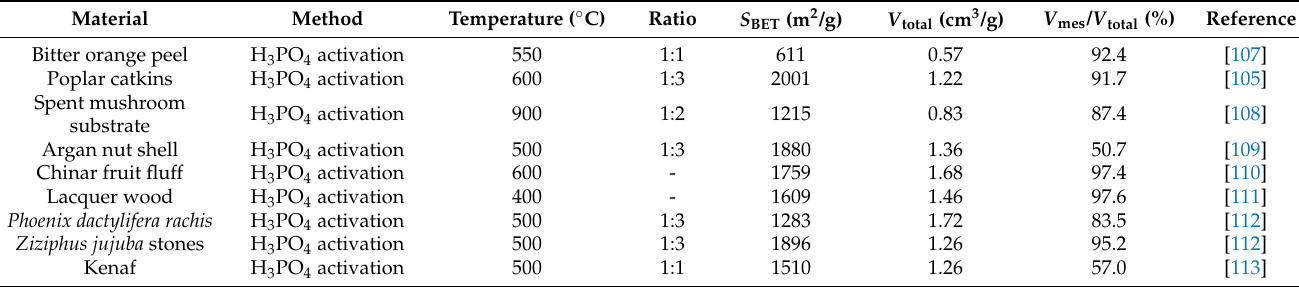
Table 3. Preparation of plant-derived carbon materials by H 3 PO 4